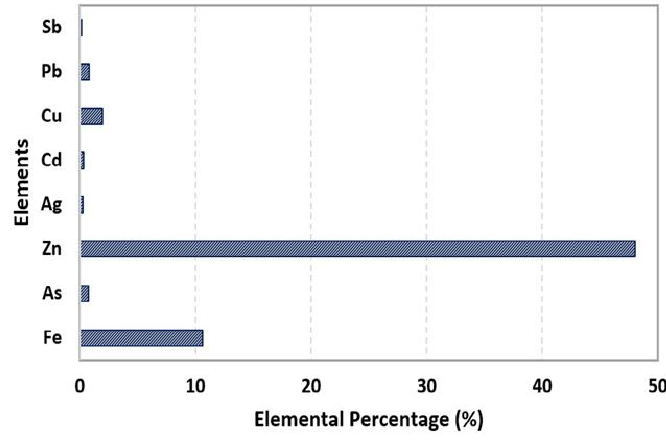
Figure 1. Average elemental composition of the concentrate of Zn. Table 1. Chemical elemental analysis of the mineral concentrate.